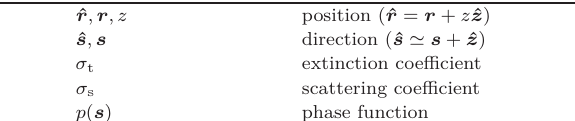
Table 1 Symbols used in equations